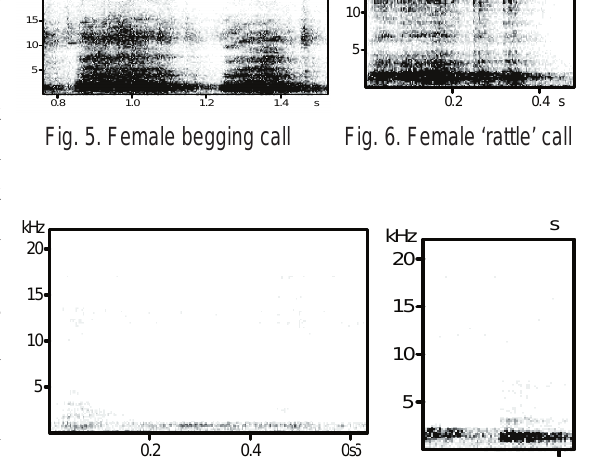
Fig. 7. Female ‘hick-up’ call Fig. 8. Male ‘click’ call